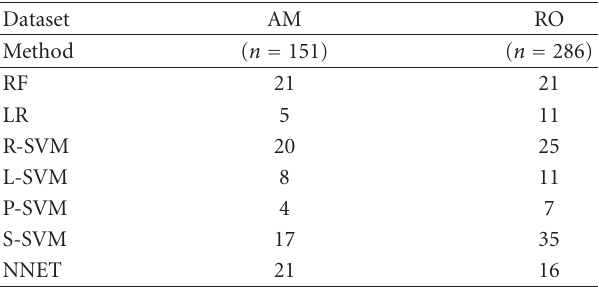
Table 2: Number of features in the